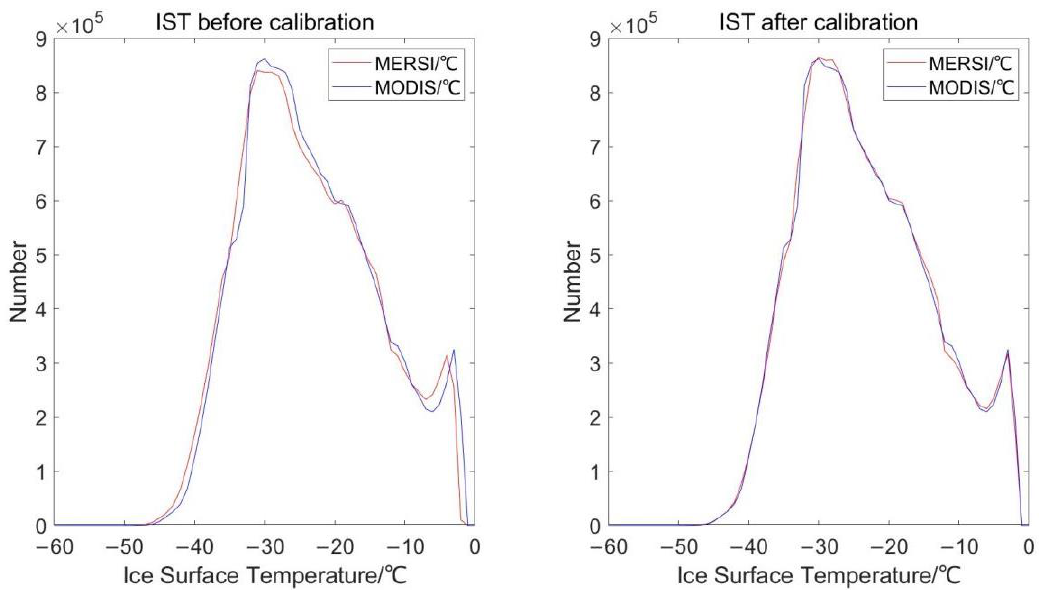
Figure 12. Statistical histogram distribution of the MODIS and MERSI IST before and after calibration from January to December.